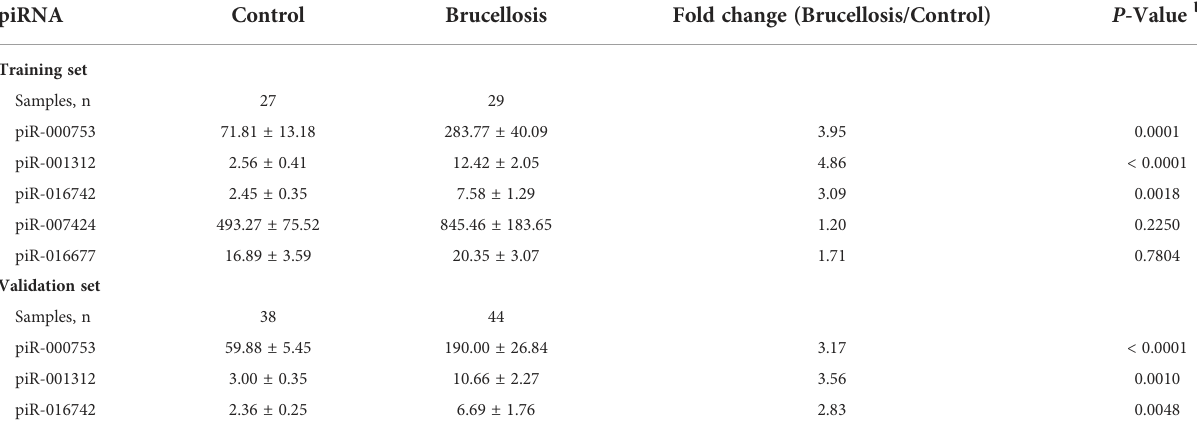
TABLE 2 Relative concentrations of candidate piRNAs to MIR2911 in the serum samples from brucellosis and control groups determined by individual qRT-PCR assay in the training set and the validation set a . piRNA Control Brucellosis Fold change (Brucellosis/Control) P -Value